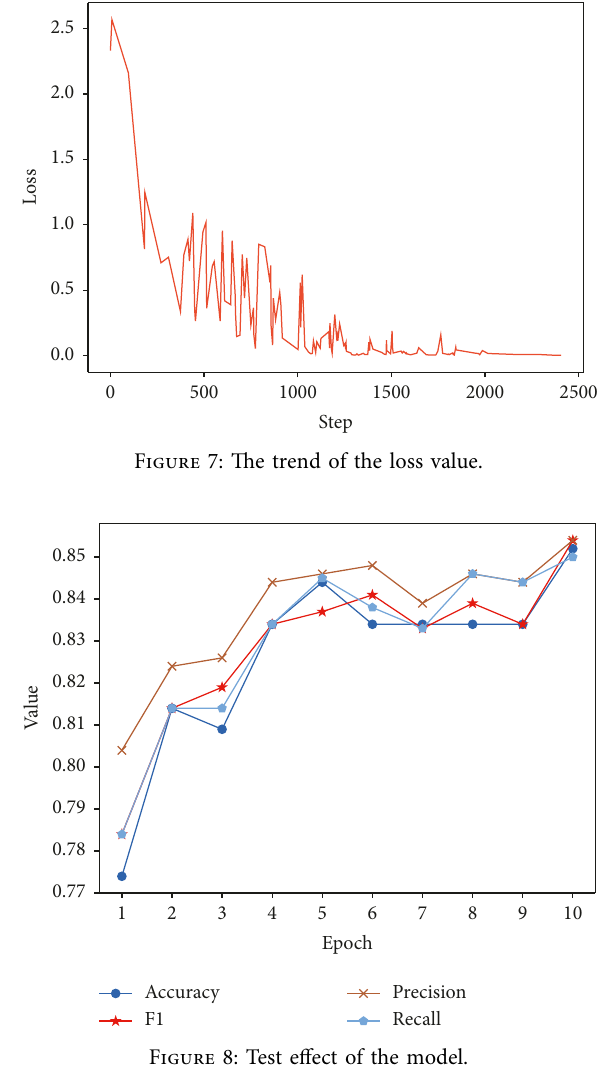
Figure 8: Test effect of the model.